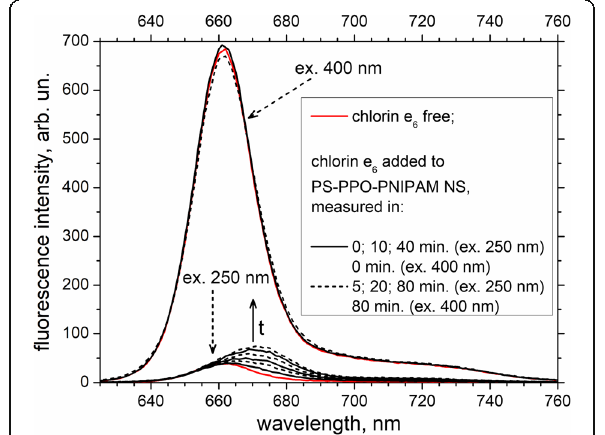
Fig. 6 Fluorescence spectra of chlorin e 6 free and added to PS- PPO-PNIPAM hybrid NS (measured in 0, 5, 10, 20, 40, and 80 min after addition). Excitation wavelengths are 250 and 400 nm; 50 mM Tris-HCl buffer, pH 7.2, was used as solvent. Short-dashed arrows indicate spectra excited at 250 and 400 nm. Solid arrow indicates the increasing time (t) after the addition of chlorin e 6 for the spectra excited at 250